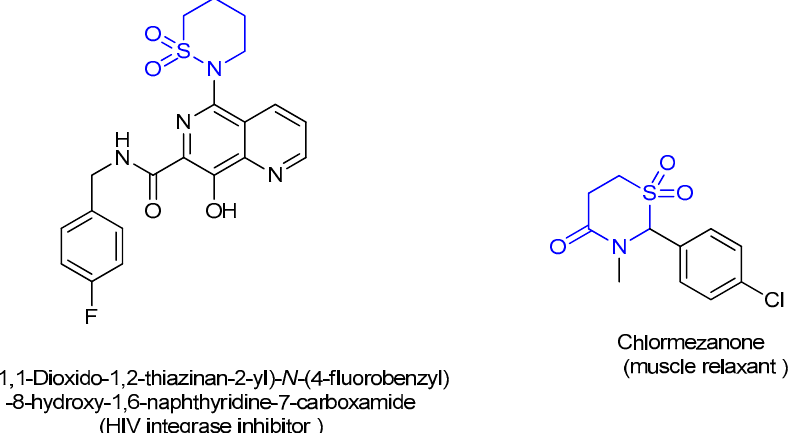
Figure 3. Structure of 1,1-dioxido-1,2-thiazinan-1,6-naphthyridine chlormezanone.